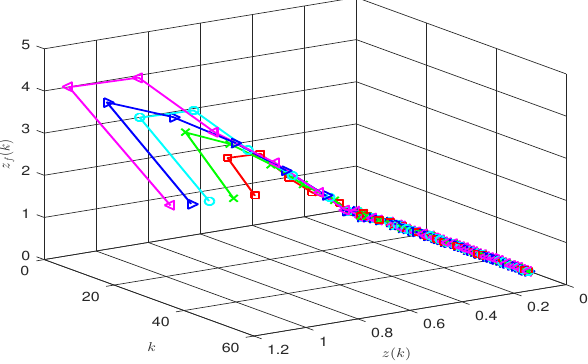
Figure 12. The simulations of z ( k ) and z f ( k ) under different initial